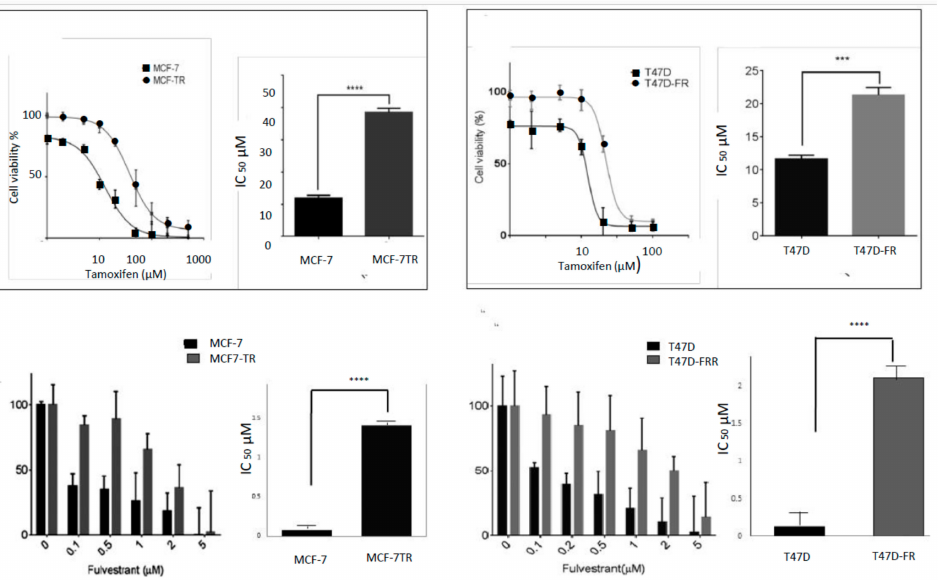
Figure 1. Assessment of tamoxifen ( upper panels ) and fulvestrant ( lower panels ) sensitivity in breast cancer cell lines. An MTT assay was used to measure sensitivity to tamoxifen and a clonogenic assay was used for assessment of fulvestrant sensitivity ( n ≥ 4). Dose–response curves were fitted using the Prism (version 6) program. IC 50 values indicating the levels of drug resistance are shown by bar graphs using a paired t -test: *** p < 0.001; **** p <